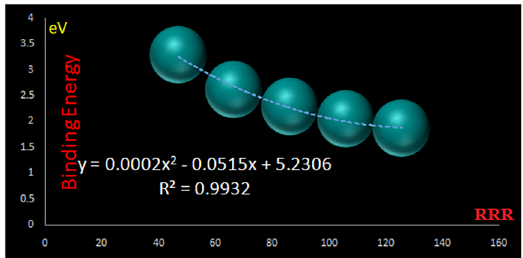
Figure 2. Binding Energy changes in Circumacenes family according to RRR index. These predictions have been performed with a precision of R 2 =0.9932 for binding energy, R 2 =0.9943 for electron affinity energy and R 2 =0.9993 for ionization energy, using equations 30, 31 and